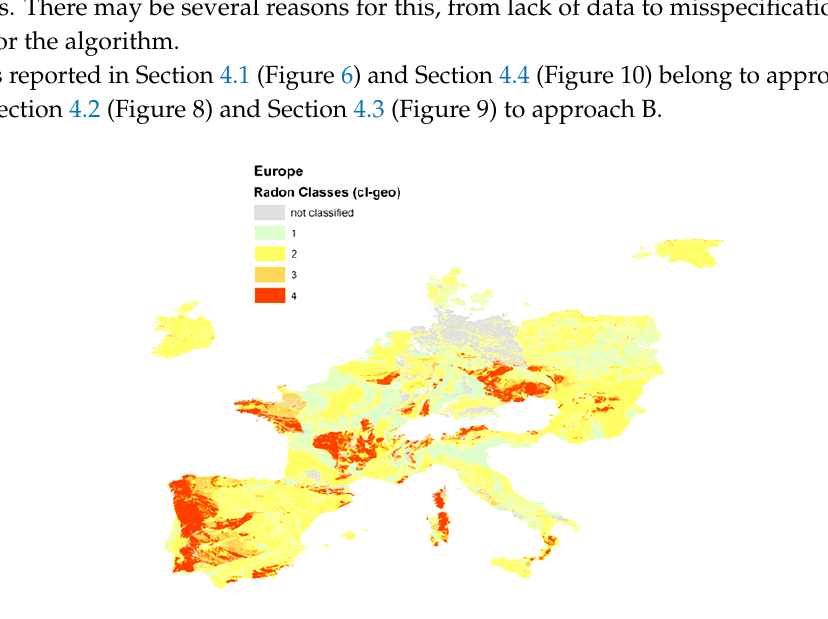
Figure 6. Classification of geological units according to the Neznal-GRP; from [112].